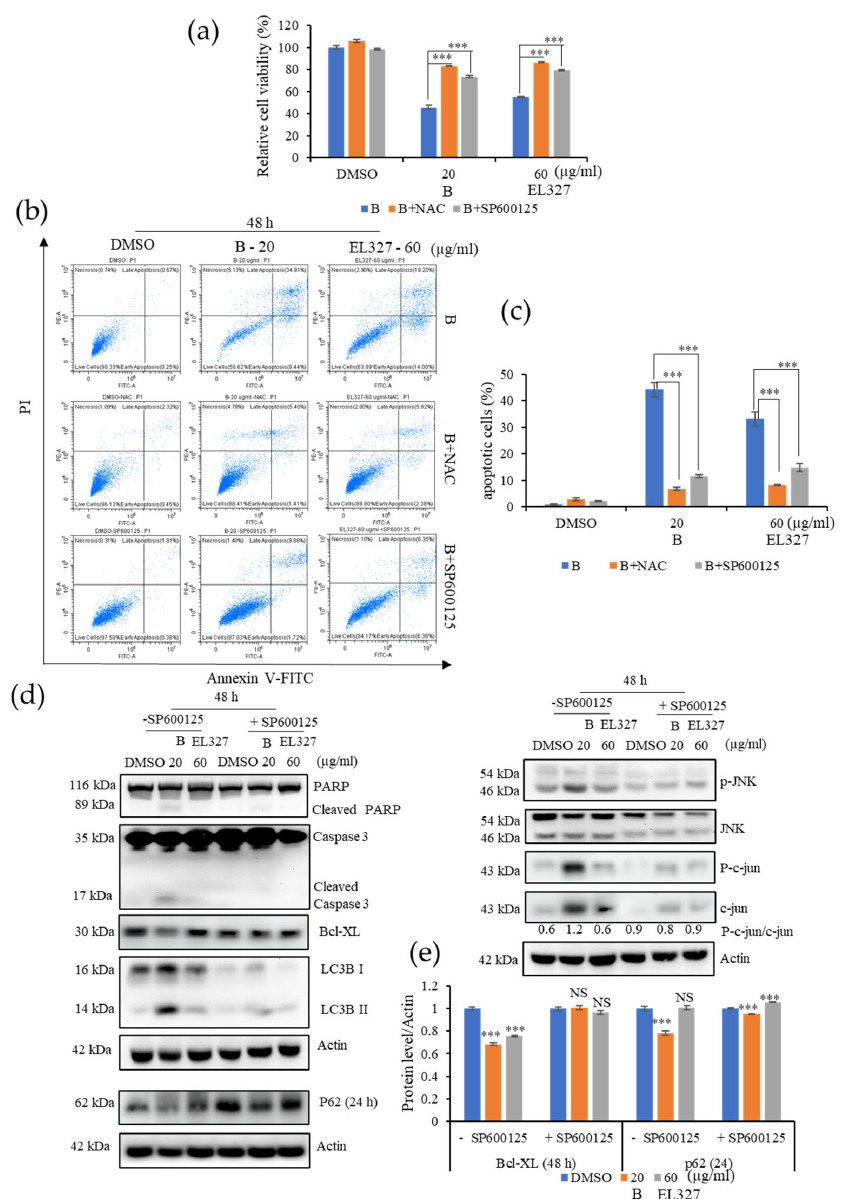
Figure 6. B activates ROS/JNK mediated apoptosis and autophagy in Caco2 cells. ( a ) The relative percentage cell viability of Caco2 cells detected after treatment with B (20 μ g/mL) or EL000327 (60 μ g/mL) for 48 h, with or without NAC (5 mM) or the JNK inhibitor SP600125 (10 μ M). ( b ) Flow cytometric analysis of dead cells stained by Annexin V ‐ FITC and PI after treatment with B (20 μ g/mL) or EL000327 (60 μ g/mL) for 48 h, with or without NAC (5 mM) or SP600125 (10 μ M). ( c ) Quantification of the percentage of apoptotic cells after treatment with the indicated concentrations of B or EL000327 for 48 h with or without NAC and SP600125 and analyzed by flow cytometry. ( d ) Western blot analysis of apoptosis, autophagy, and the JNK signaling pathway related protein expression in Caco2 cells treated with B (20 μ g/mL) or EL000327 (60 μ g/mL) for 24 or 48 h, with or without SP600125 (10 μ M). ( e ) Quantification of Bcl ‐ XL and p62 protein expressions in the presence or absence of SP600125. Data represent the mean ± S.D. *** p < 0.001 compared with the NAC ‐ and SP600125 ‐ treated groups or the DMSO ‐ treated control. NS: no significant difference.